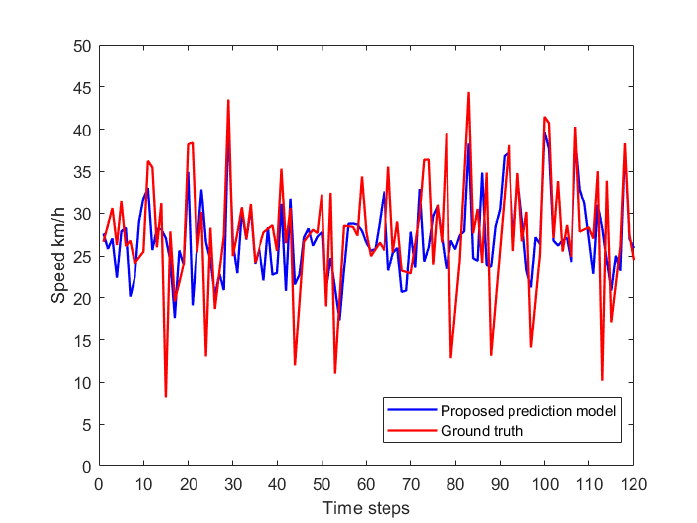
Figure 7. The comparison cavers under 30 min forecasting interval.